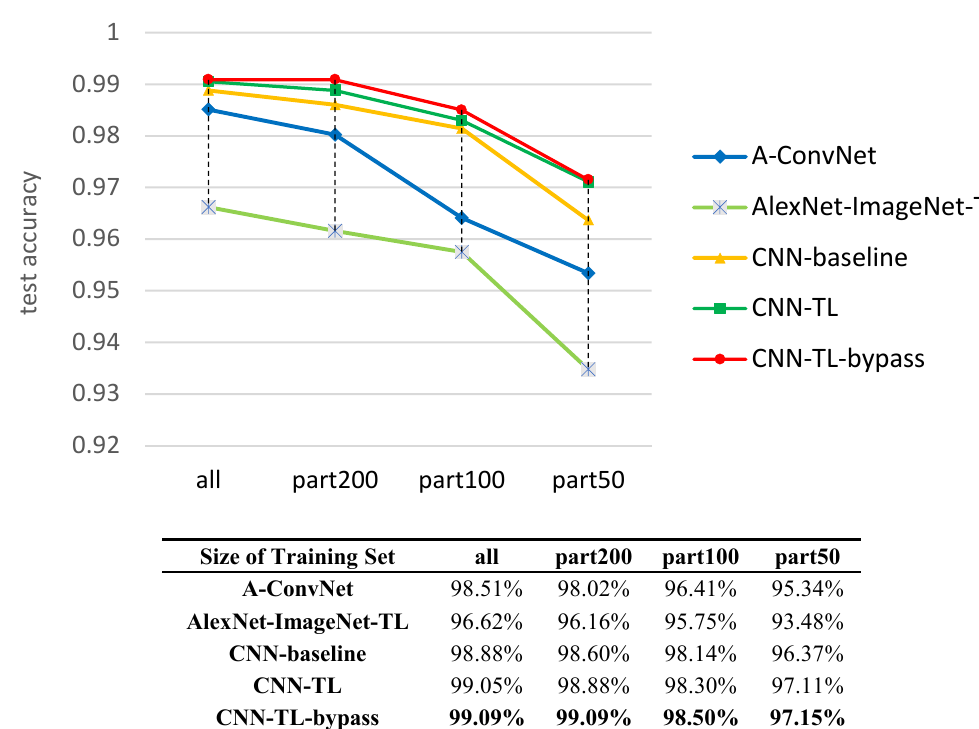
Figure 13. Recognition rate of different methods with reducing training